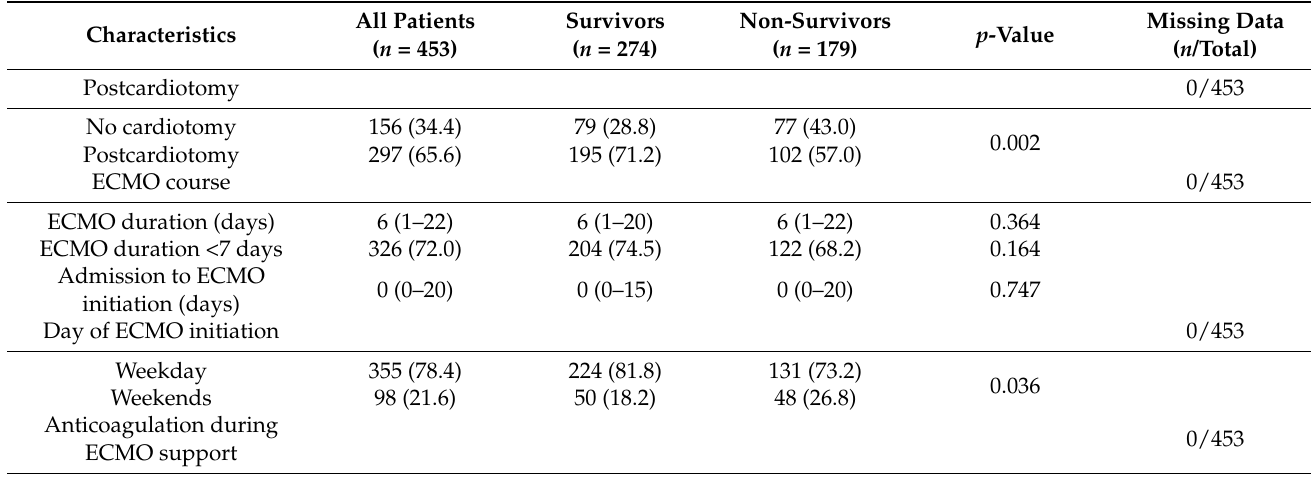
Table 2. ECMO support characteristics and patient outcomes ( n = 453, in-hospital